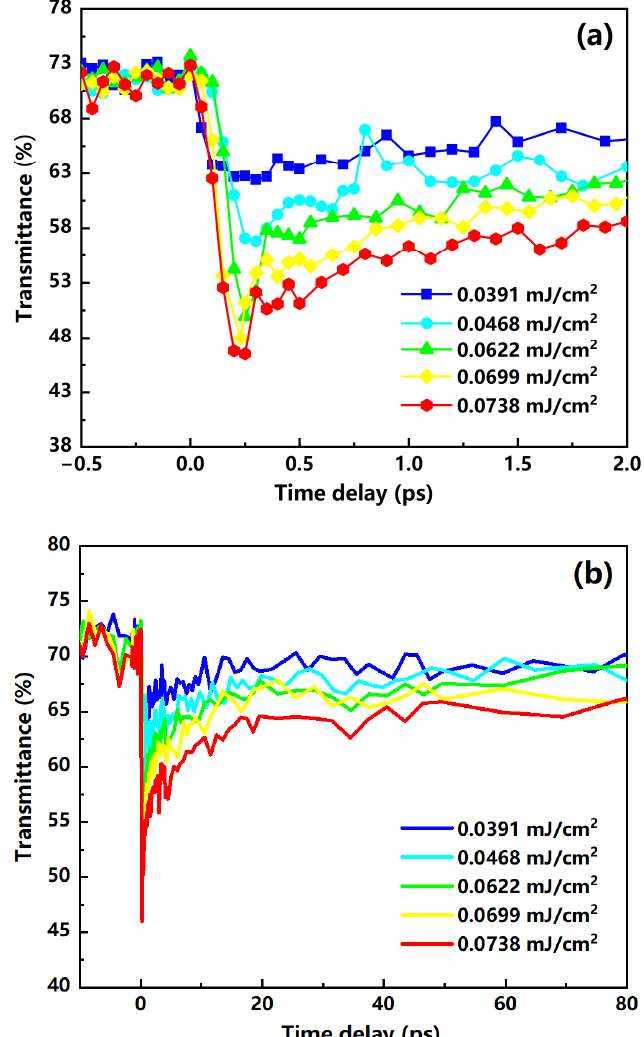
Figure 9. Different energy density laser pulse-induced transient transmittance changes in the V 2 O 5 film on the Al 2 O 3 substrate. ( a ) Partial data; ( b ) full-track data.